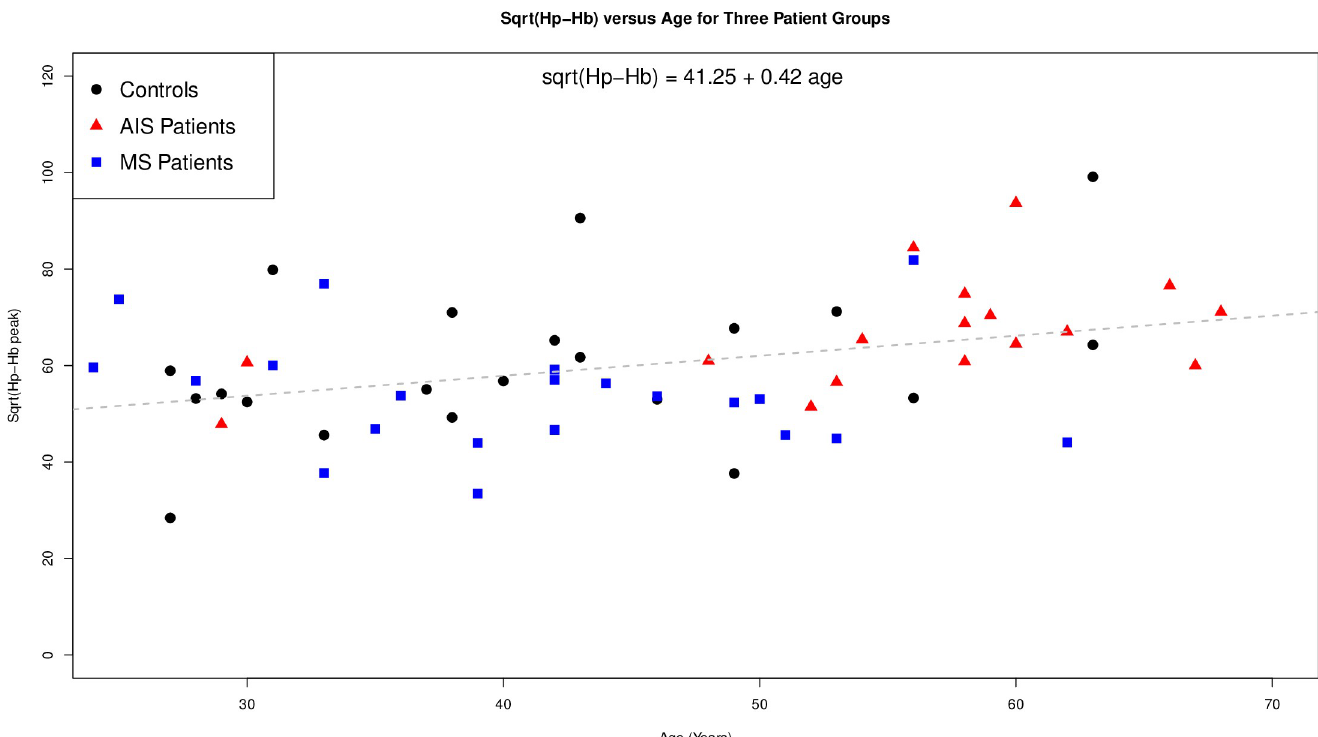
Fig 2. Plot of the age of the participants (AIS, MS and control: x-axis) against the square root of the obtained Fe-peak areas corresponding to the Hp-Hb complex (y-axis). The regression line is for all data (adjusted R 2 of 0.11, F(1,57) = 8.58, p = 0.005) and ignores which group people are in, but clearly depicts a positive association between the age of the individual and the Hb-Hp peak